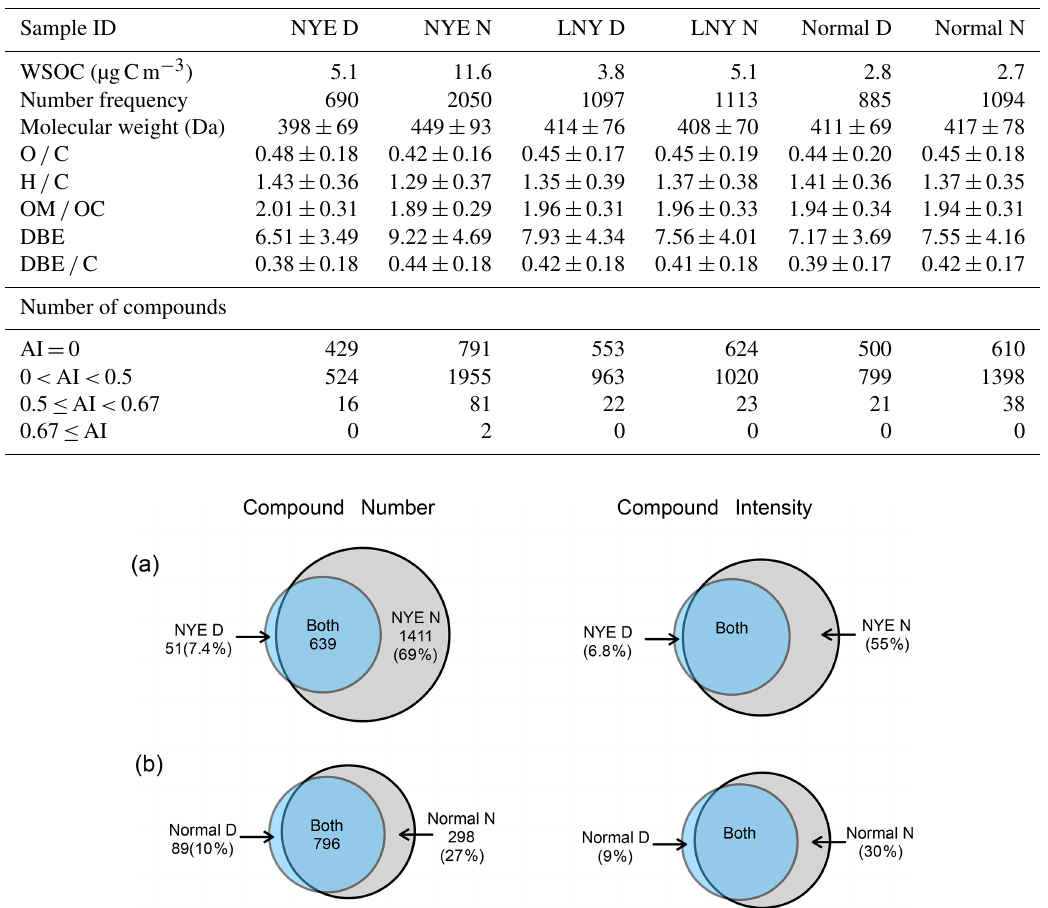
Table 1. The concentrations of chemical components and the number and elemental characteristics of nitrooxy OSs in the Beijing aerosol samples.